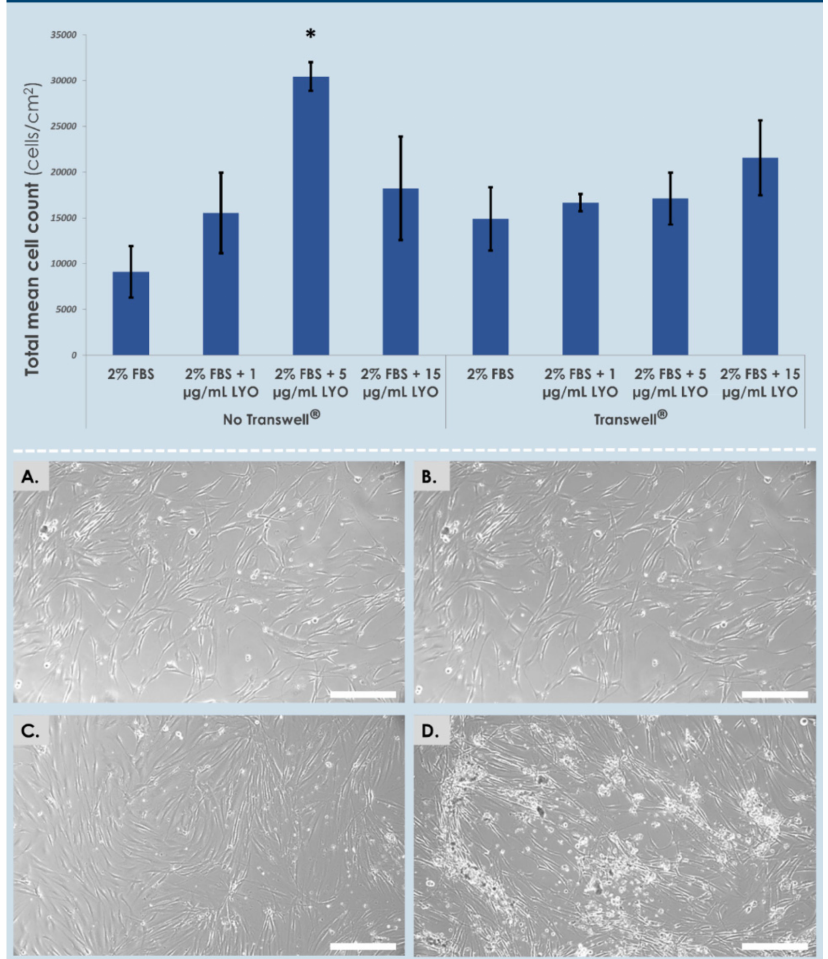
Figure 7. Primary juvenile fibroblast cell proliferation stimulation potential of various doses (i.e., expressed in normalized total protein contents at the final dilution in the culture medium) of dermal FPC (e.g., FE002-SK2 cell type) lyophilizates (i.e., “LYO”, formula M). The culture medium contained 2% v / v FBS. Photographic imaging was performed 48 h following the second treatment with the test-items. ( A ) Control group, no Transwell ® insert. ( B ) Lyophilizate group at a concentration of 1 µ g/mL, no Transwell ® insert. ( C ) Lyophilizate group at a concentration of 5 µ g/mL, no Transwell